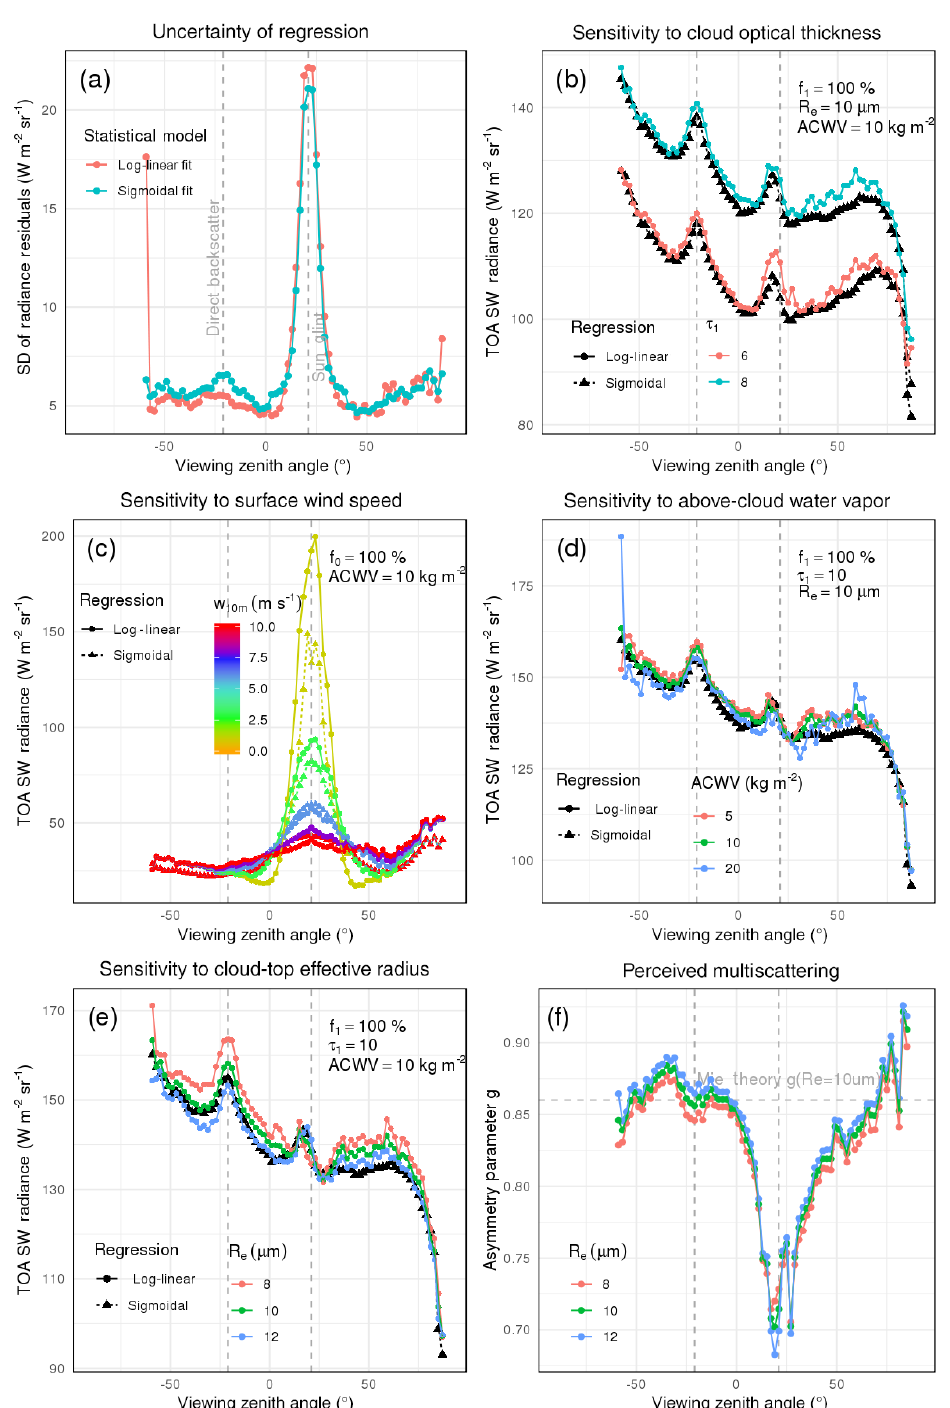
Figure 5. For angular bins along the principal plane for θ 0 ∈ [ 20 ◦ , 22 ◦ ] containing liquid-phase footprints, we present error metrics and sensitivities of proposed log-linear vs. state-of-the-art sigmoidal fits. Panel (a) shows the SD of residuals; colors mark the type of fit. Panel (b) displays the optimal g( R e ) for three R e (by color). Panels (c) , (d) , and (e) demonstrate predicted radiances by both fits for varying cloud optical thickness (c) , cloud-top effective radius (d) , and above-cloud water vapor (e) . Predictions from log-linear fits are colored, while predictions from sigmoidal fits are shown in black. Panel (f) presents the response of both fits to a variety of surface wind speeds. Properties held constant in panels (c) , (d) , (e) , and (f) are listed in the each panel’s top-right